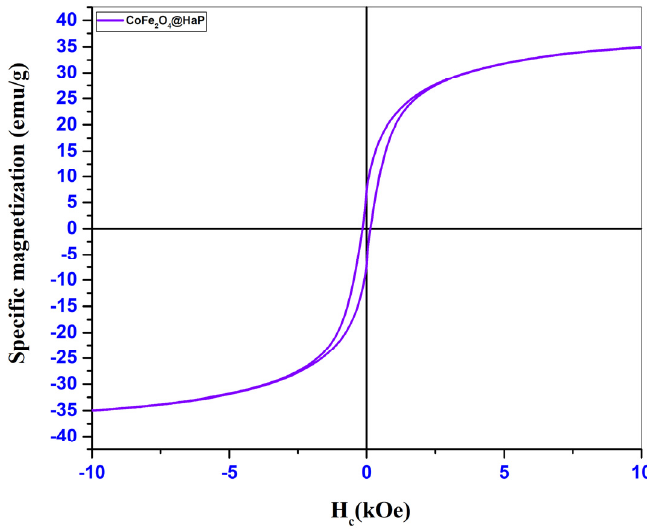
Figure 5. Magnetization of CoFe 2 O 4 sample.